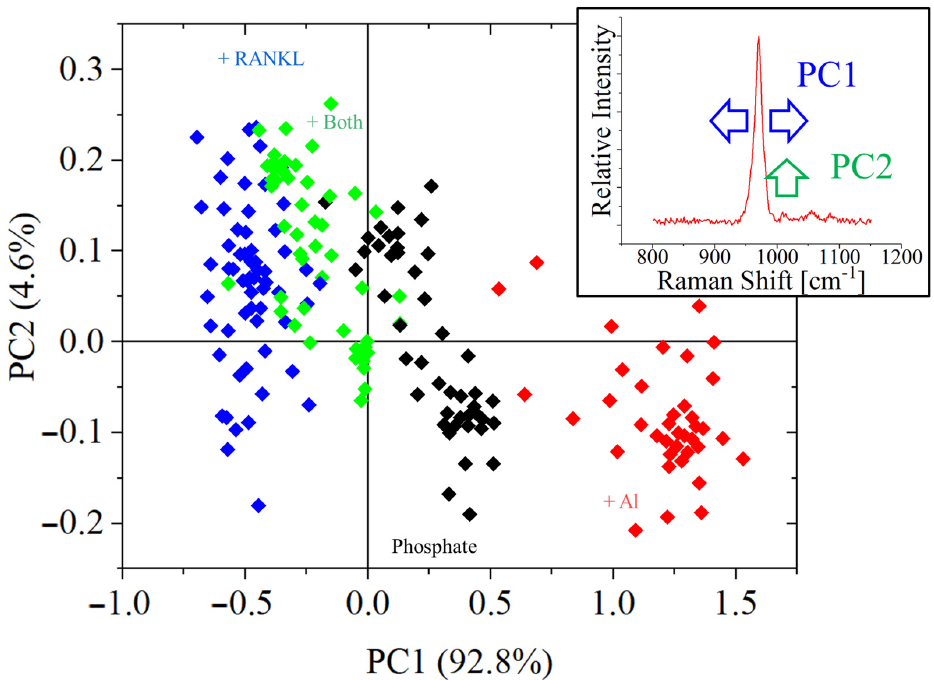
Figure 11. PCA analysis for the hydroxyapatite region of the octacalcium phosphate samples, PC1 related to the bandwidth of the 960 cm − 1 phosphate vibration and PC2 related to the intensity of the phenylalanine band at about 1004 cm − 1 .